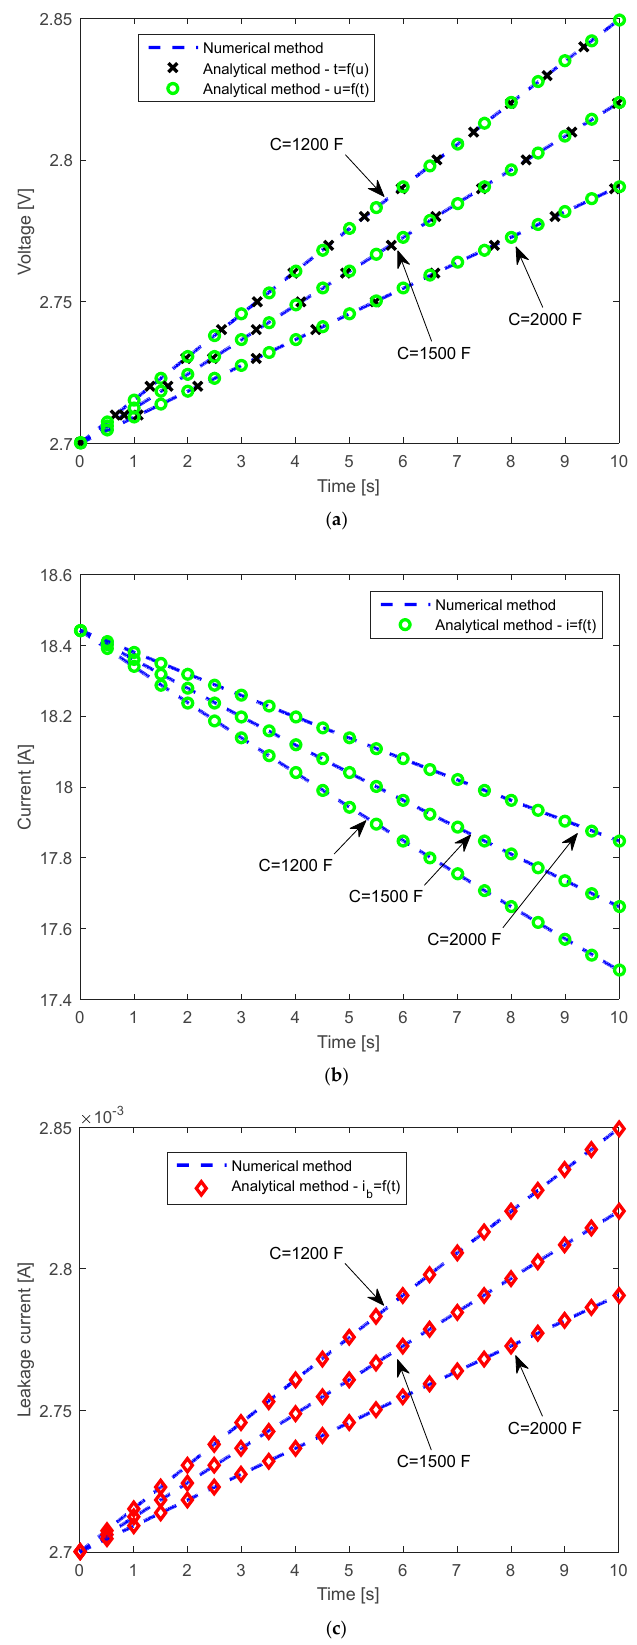
Figure 9. Charging mode characteristics at different capacitance values: ( a ) voltage versus time; ( b ) current versus time; ( c ) leakage current versus time; P = 50 W, R b = 1000 Ω , and R = 0.58 m Ω .